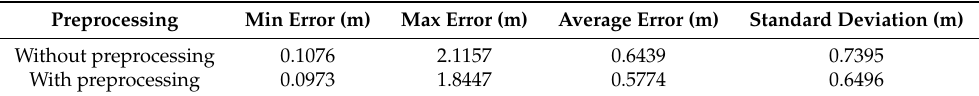
Table 1. The Influence of Preprocessing.